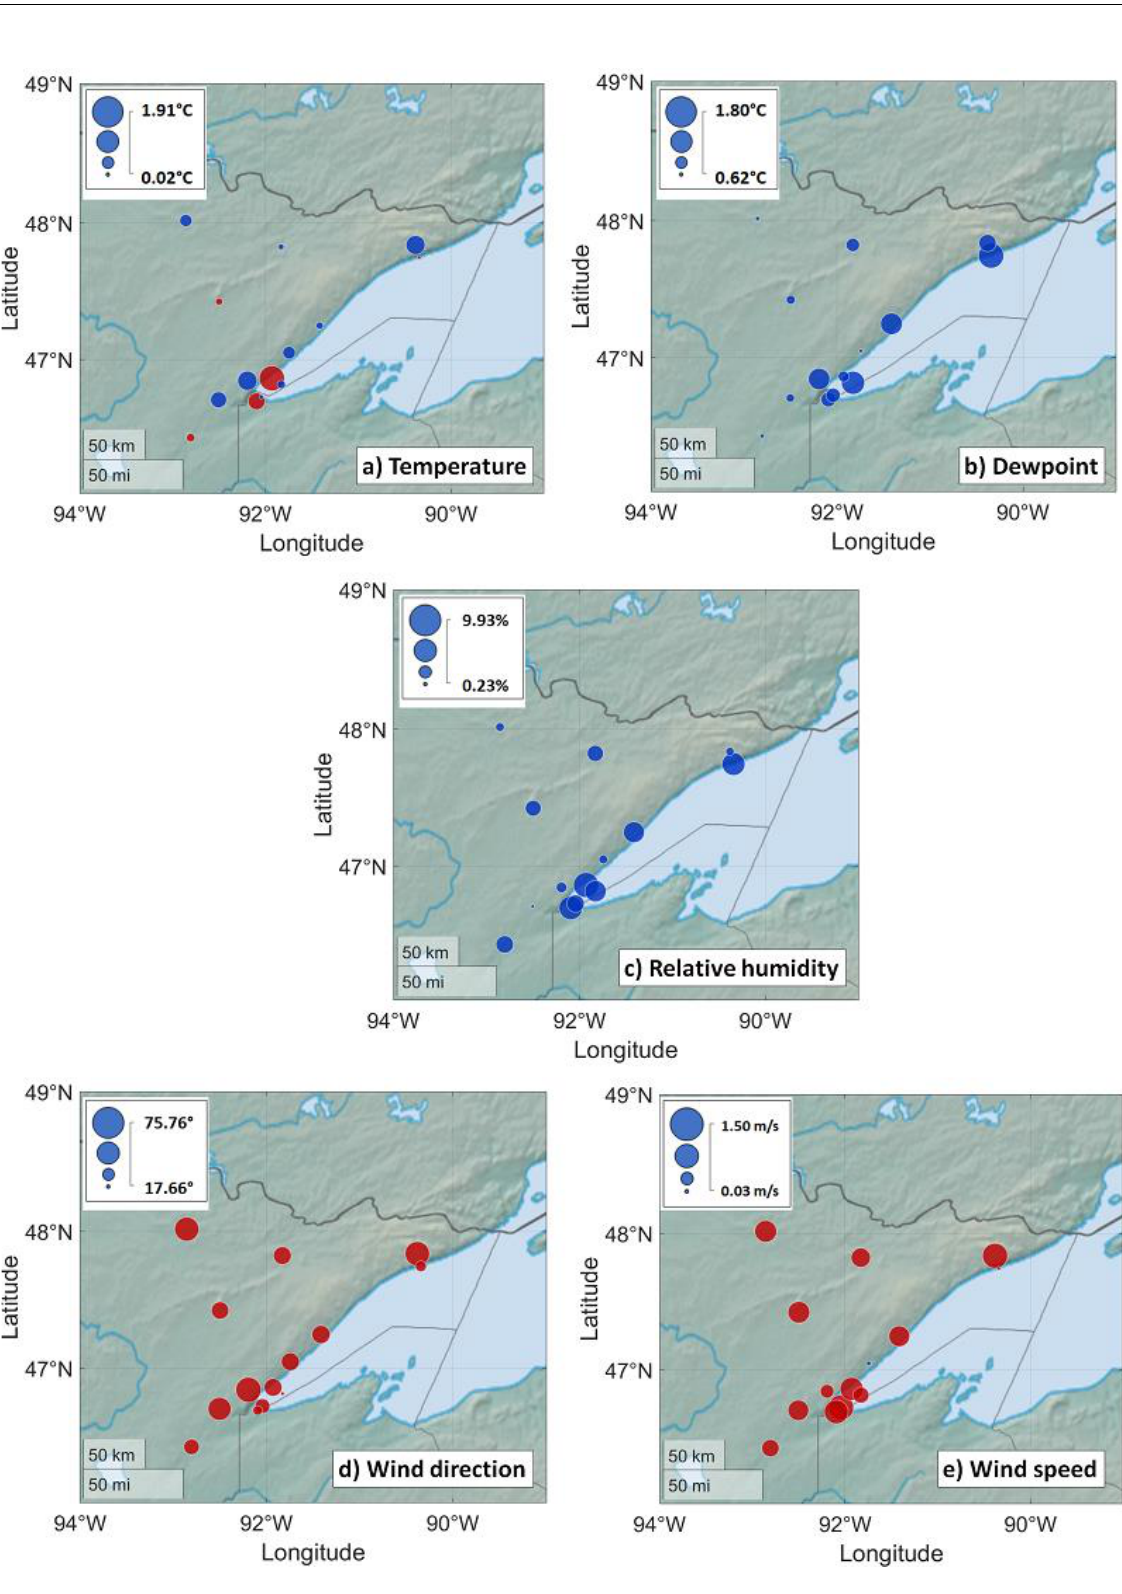
Figure 2. Average changes experienced over all cold fronts: ( a ) temperature, °C (red [blue] indicates warming [cooling]); ( b ) dewpoint, °C (blue indicates a decrease); ( c ) relative humidity, % (blue indicates a decrease); ( d ) wind direction (red indicates the wind’s northerly component increasing with time); ( e ) wind speed, m s −1 (red [blue] indicates a strengthening [weakening] wind). Bubbles are sized according to the magnitude of change at each station. Made with Natural Earth.